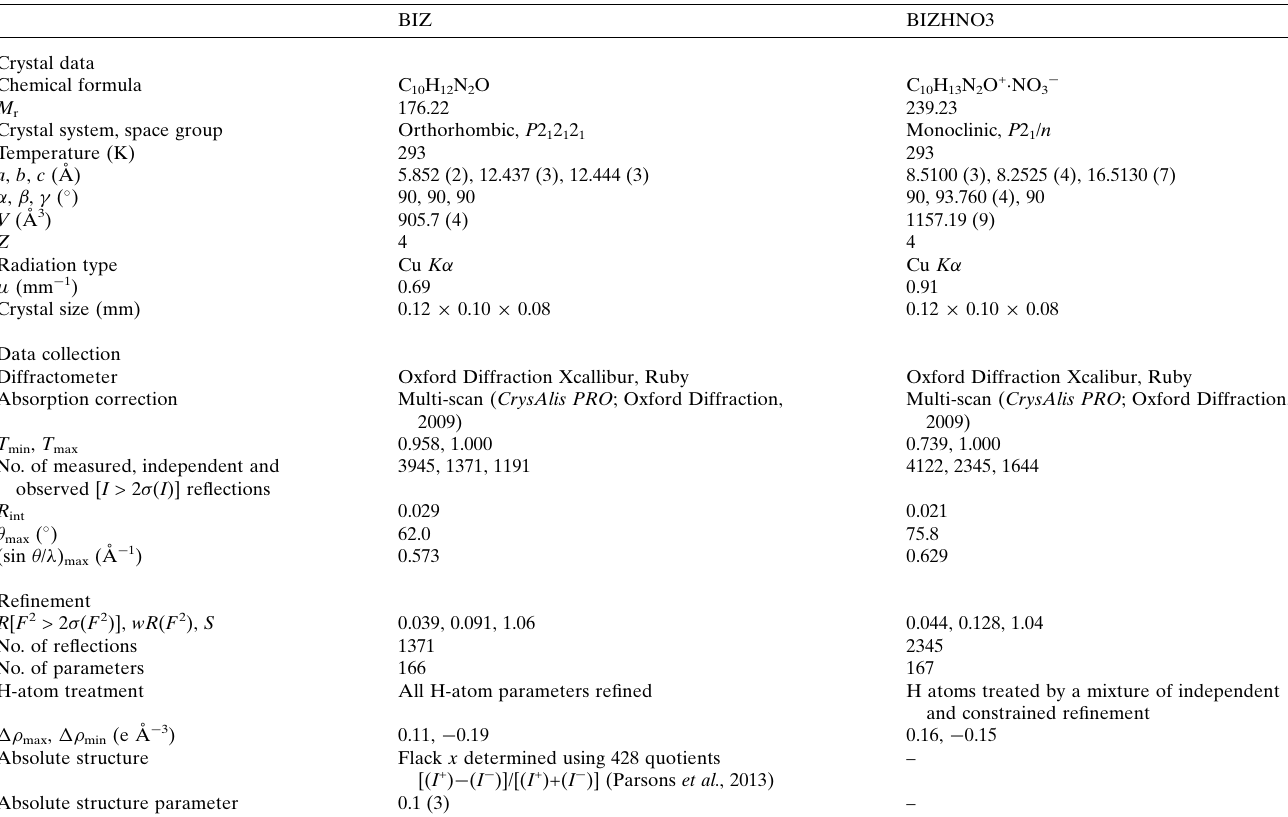
Table 3 Experimental details.